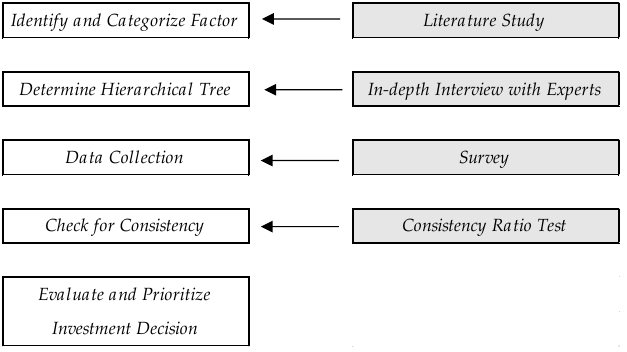
Figure 1. Flow diagram of the decision factor framework.